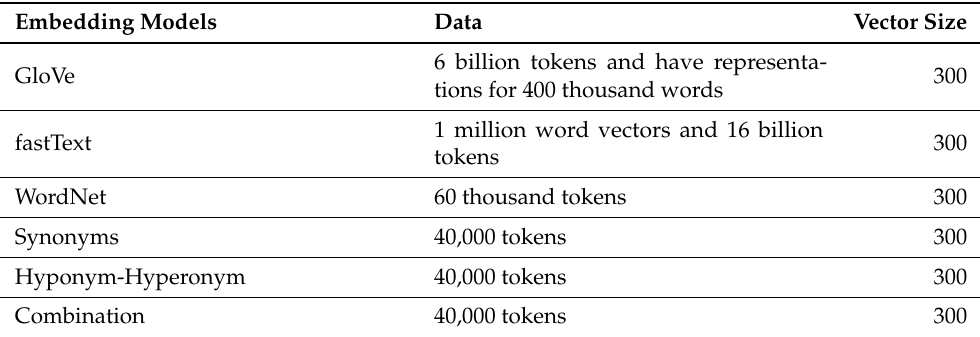
Table 6. Embedding